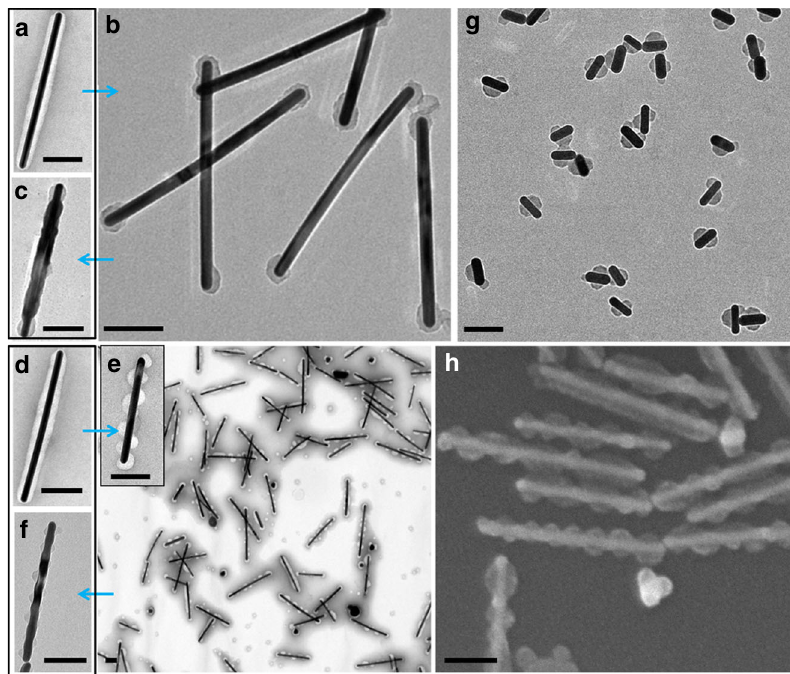
Fig. 3 Dissociation and winding modes. a , b TEM images of the (AuNR- 3 )@PSPAA before a and after b heating in water at 90 °C for 3 h. c TEM image of the transformed (AuNR- 3 )@PSPAA after Ag deposition on the exposed Au surface. d , e TEM images of the (AuNR- 6 )@PSPAA before d and after e heating in water at 60 °C for 3 h. The inset in e is the TEM image of the transformed (AuNR- 6 )@PSPAA with high magni fi cation. f TEM image of the transformed (AuNR- 6 )@PSPAA after Ag deposition. g The shorter (AuNR- 6 )@PSPAA after shell transformation. h SEM image of the transformed (AuNR- 6 )@PSPAA. The scale bars are 100